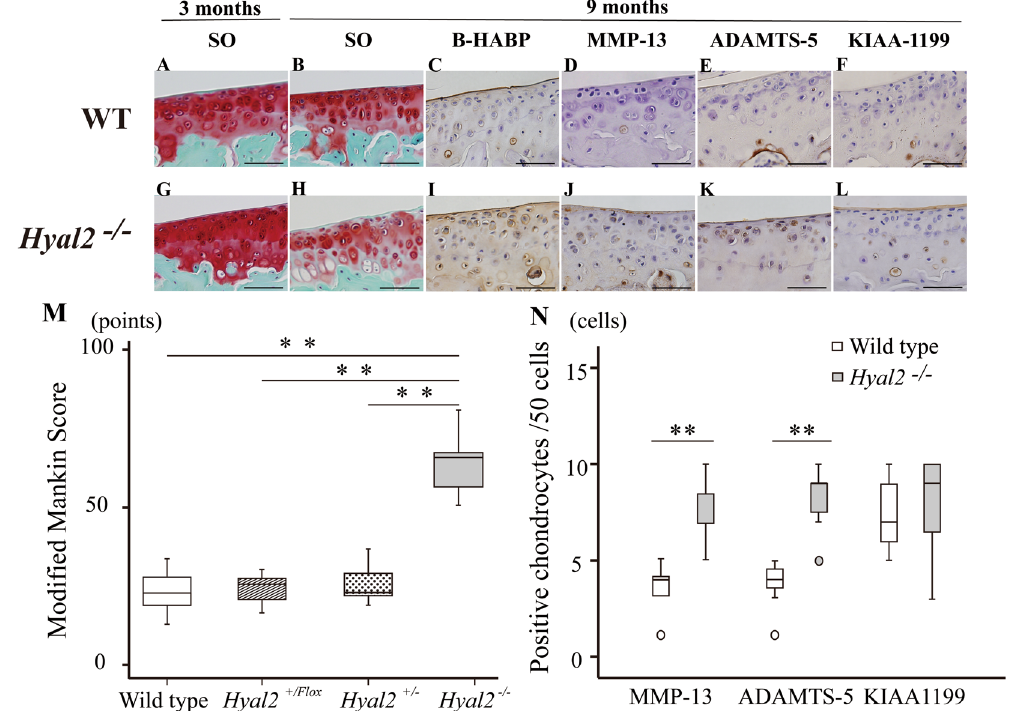
Figure 1. Histologic analysis of structural damage of articular cartilage in natural course of WT and Hyal2 − / − mice at 3 and 9 months of age. Safranin-O staining (SO): WT and Hyal2 − / − mice at 3 months (A and G, respectively) and 9 months (B and H, respectively). B-HABP staining: WT and Hyal2 − / − mice at 9 months (C and I, respectively). Immunohistochemical staining for MMP-13: WT and Hyal2 − / − mice at 9 months (D and J, respectively). Immunohistochemical staining for ADAMTS-5: WT and Hyal2 − / − mice at 9 months (E and K, respectively). Immunohistochemical staining for KIAA1199: WT and Hyal2 − / − mice at 9 months (F and L, respectively). Scale bars depict 50 μ m in length. Modified Mankin score of medial tibia in WT and Hyal2 − /